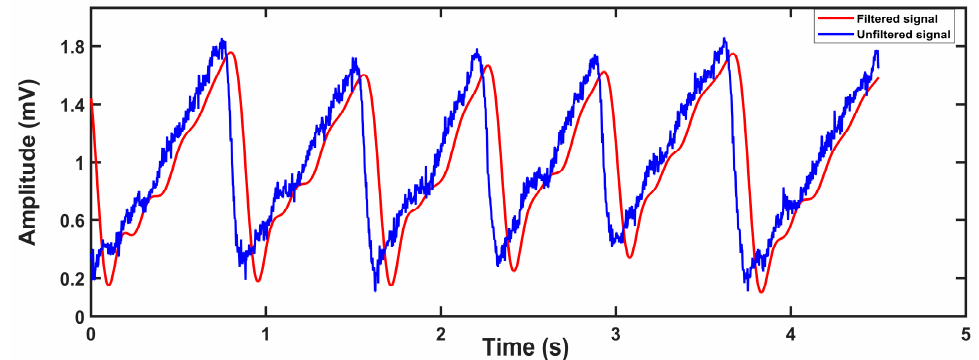
Figure 14. Filtered effect of digital IIR filter.